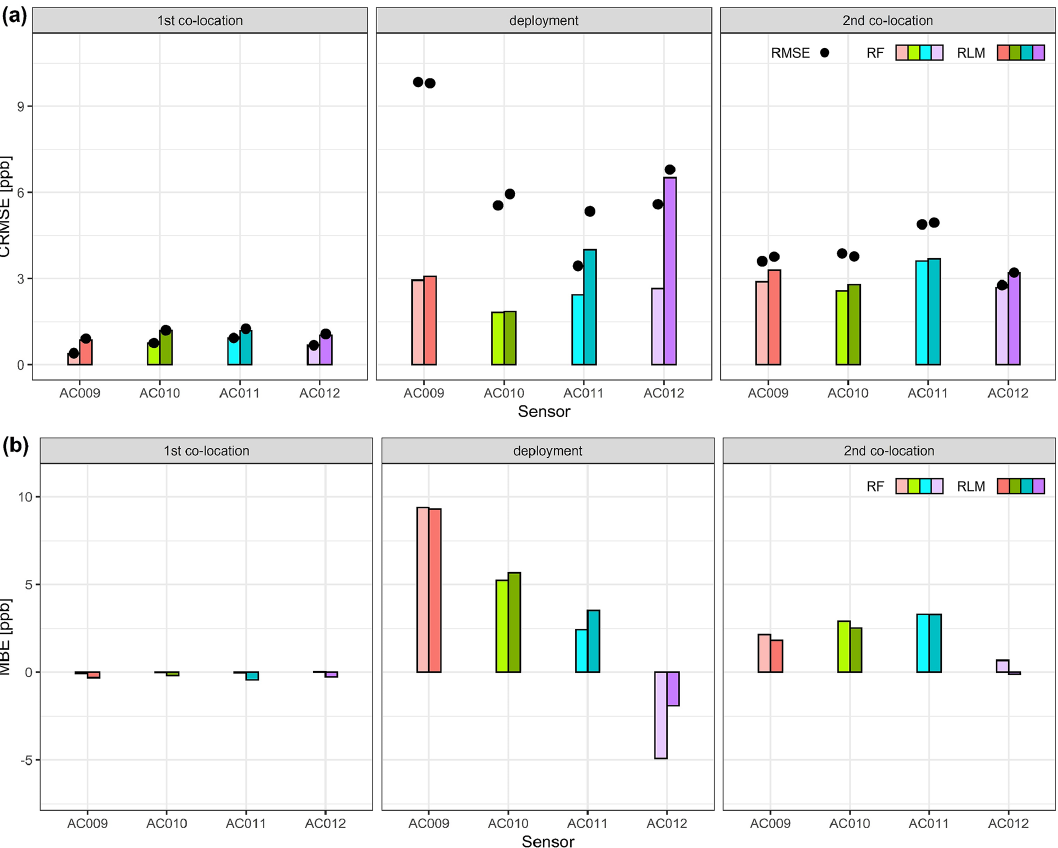
Figure 8. RMSE and CRMSE (a) as well as MBE (b) for NO 2 during the co-location periods and the deployment period. The metrics for the co-location periods are also calculated from biweekly averaged data in order to facilitate the comparison with sensor performance during